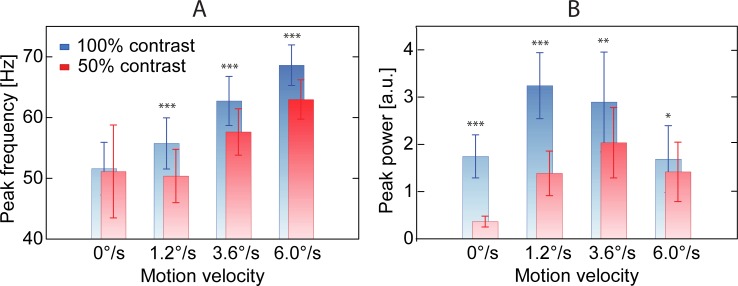
Grand average peak frequency (A) and power (B) of cortical GRs as a function of Contrast and motion Velocity. Vertical bars denote 0.95 confidence intervals. *** p<0.001; ** p<0.01; * p<0.05.